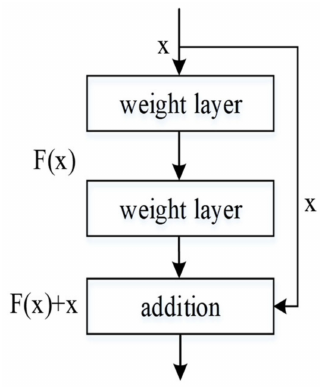
Figure 1. Residual block structure.